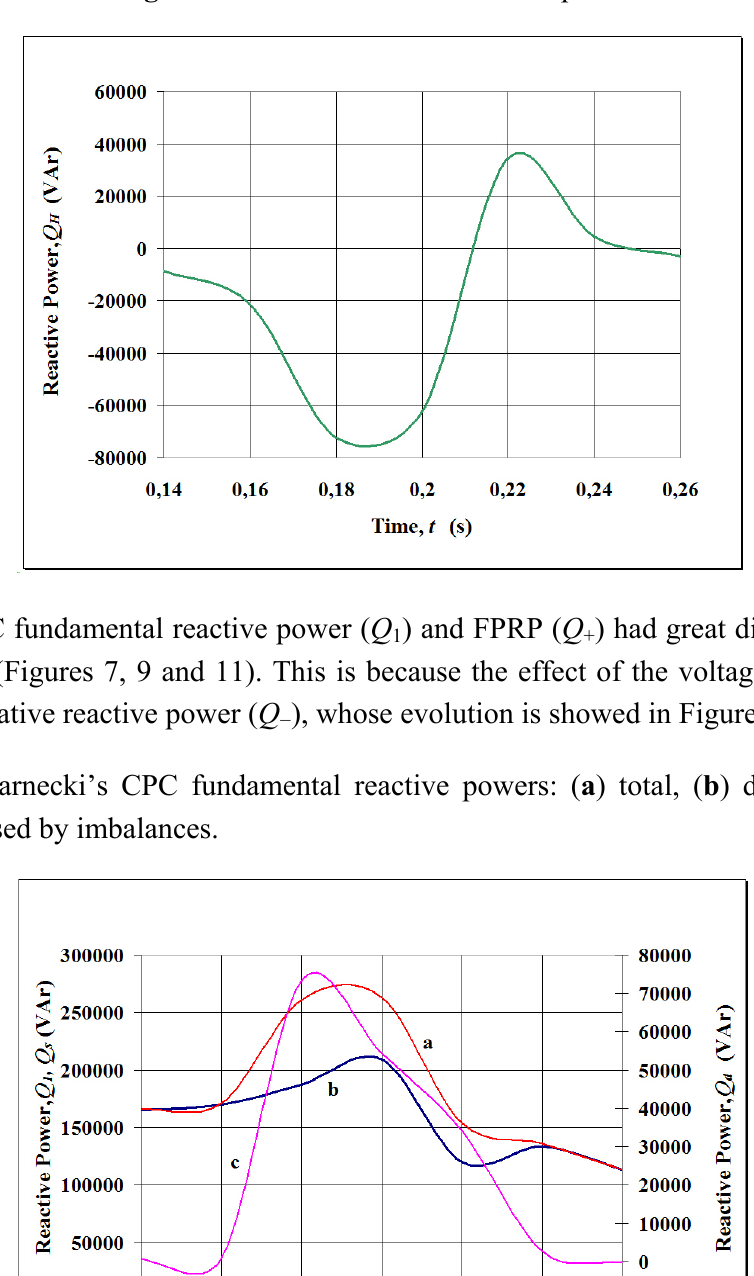
Figure 8. Non-fundamental reactive